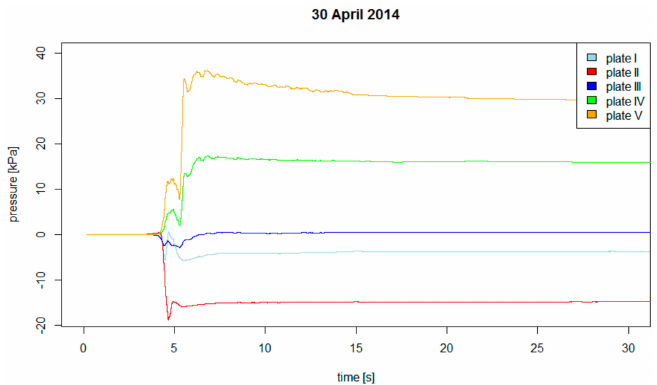
Figure 15. Time evolution of the pressure on the di ff erent plates for the five selected avalanches (data averaged over 0.2 s).